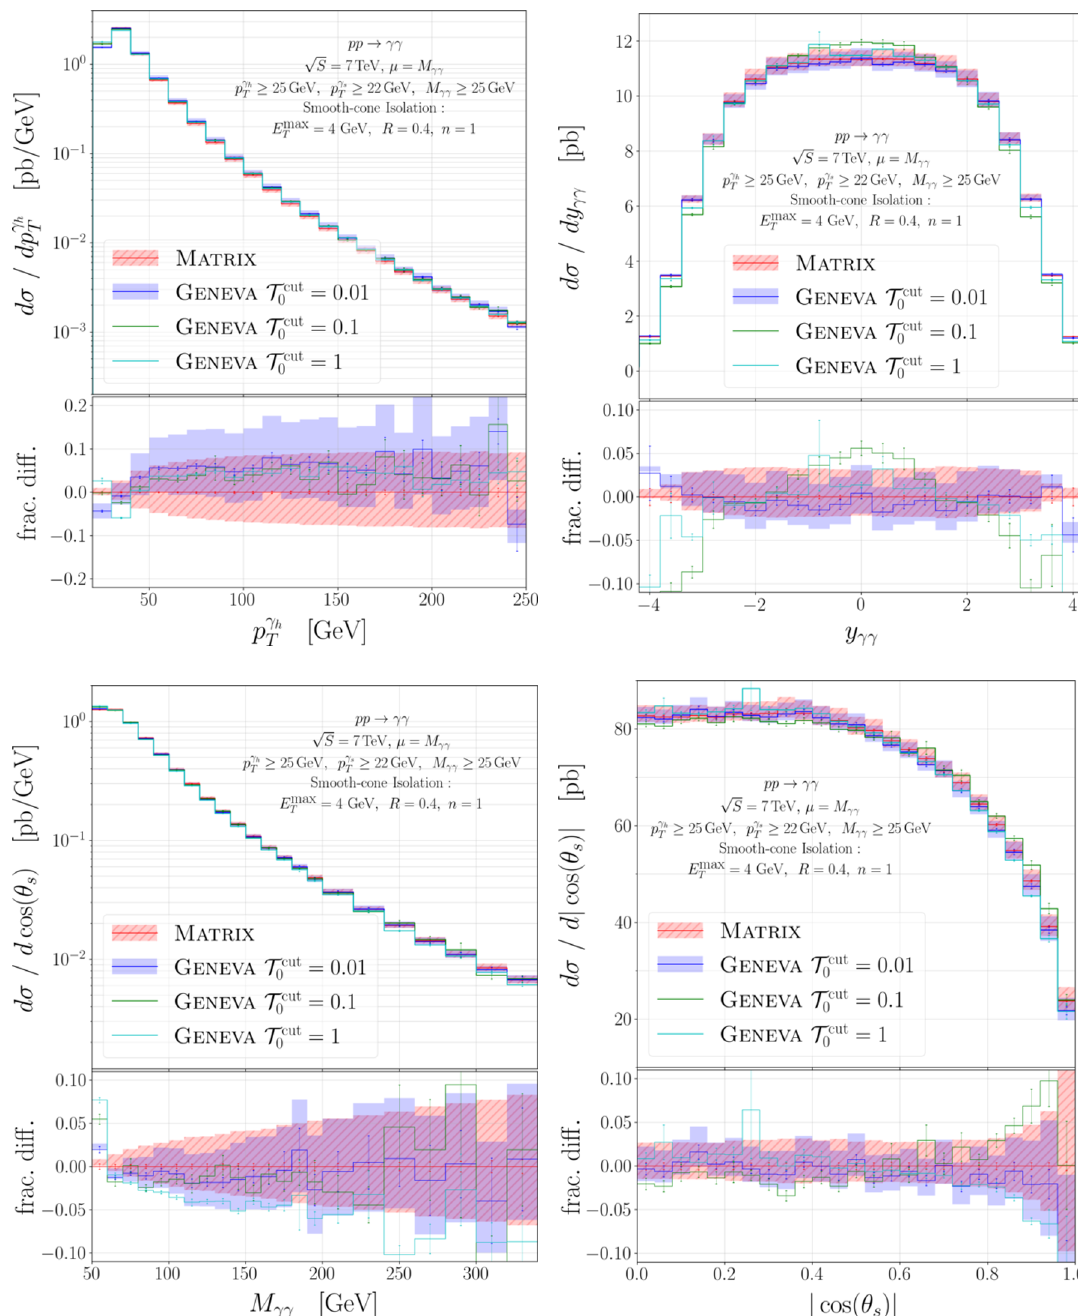
Figure 6 . Comparison between Matrix and Geneva for different values of T cut transverse momentum of the hardest photon (top left), rapidity of the diphoton system (top right), invariant mass of the diphoton system (bottom left) and the cosine of the photon scattering angle (bottom